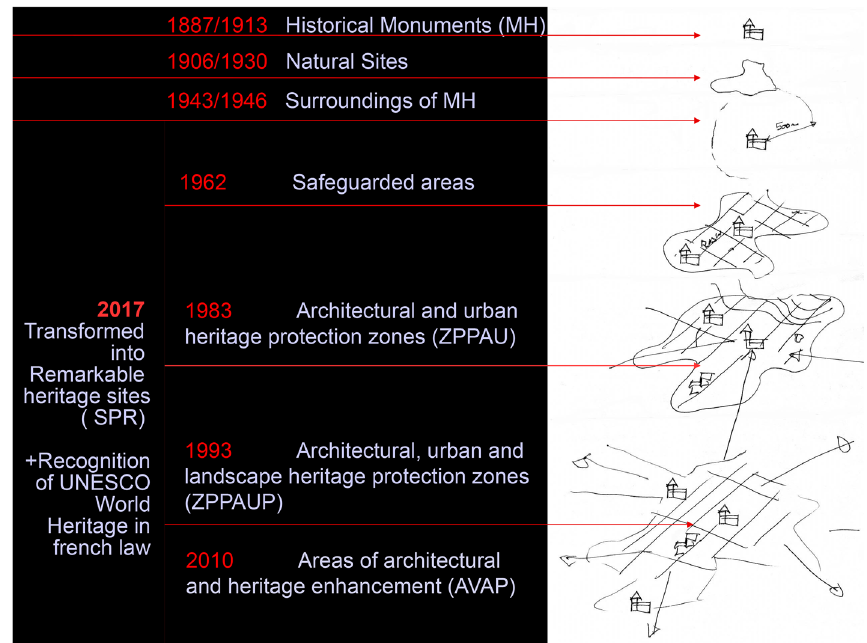
Fig. 7 Table summarising the evolution of heritage protection laws in France: from historical monuments (object) to landscapes and inhabited territories (Source: Alain